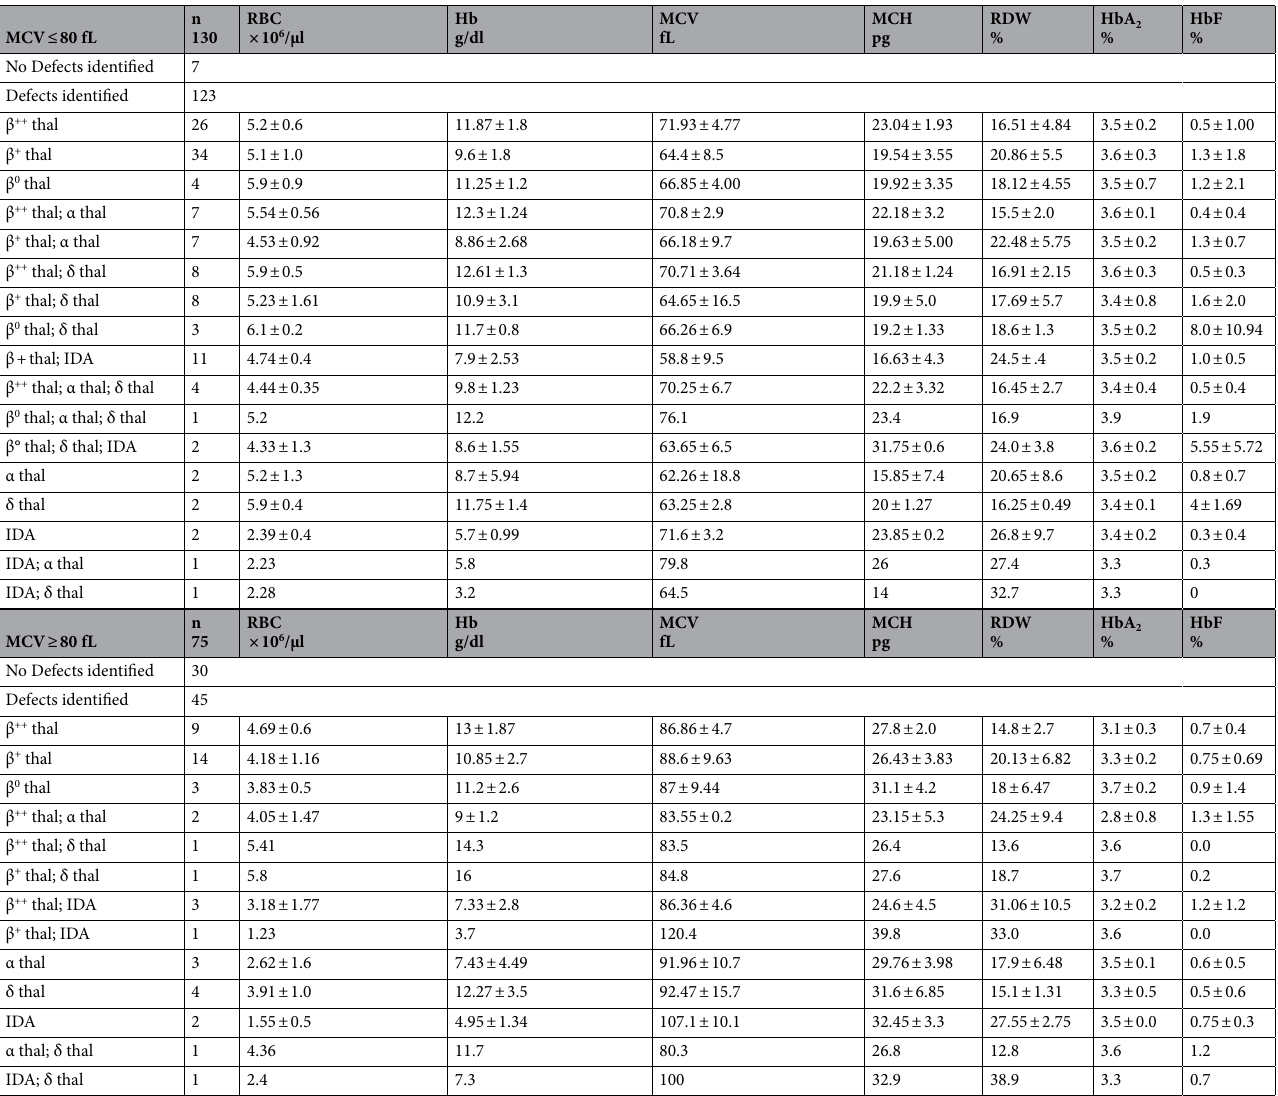
Table 3. Hematological analysis of the individuals with MCV ≤ 80 fL and MCV ≥ 80